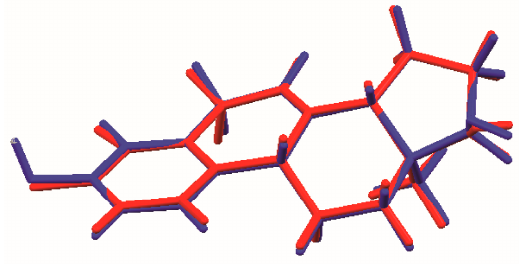
Figure 6. Comparison of the Rietveld refined (red) and DFT optimized (blue) structures of 17 α -dihydroequilin.